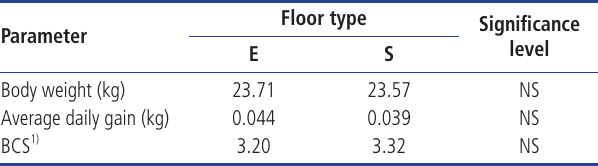
HE, herded goats accommodated on earth floors; HS, herded goats accommodated on